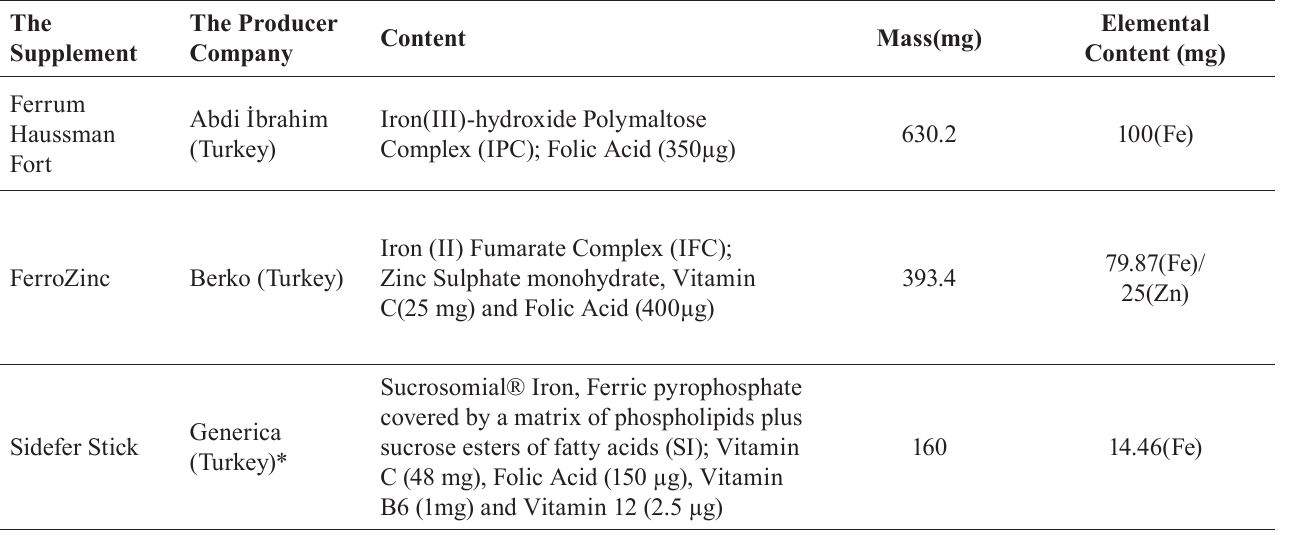
TABLE II - The analyzed dietary supplement name, content and producer company The